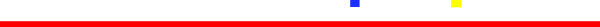
Schematics of cleavage-sites by ZFNs along the darc gene. This figure graphically illustrates the sites and frequency of ZFN cleavage of the darc gene. Two ZFN cleaving at positions approximately 0.5 and 0.75 within the context the darc gene are shown, although others could be re-engineered by the methods described in the text
[22,23,28]. Hits (blue, green, and gold bars) represent targets along the gene (red bars). ZFN hits in the graphic are color-coded based on spacer size (5 bp = Blue; 6 bp = Green; 7 bp = Gold).